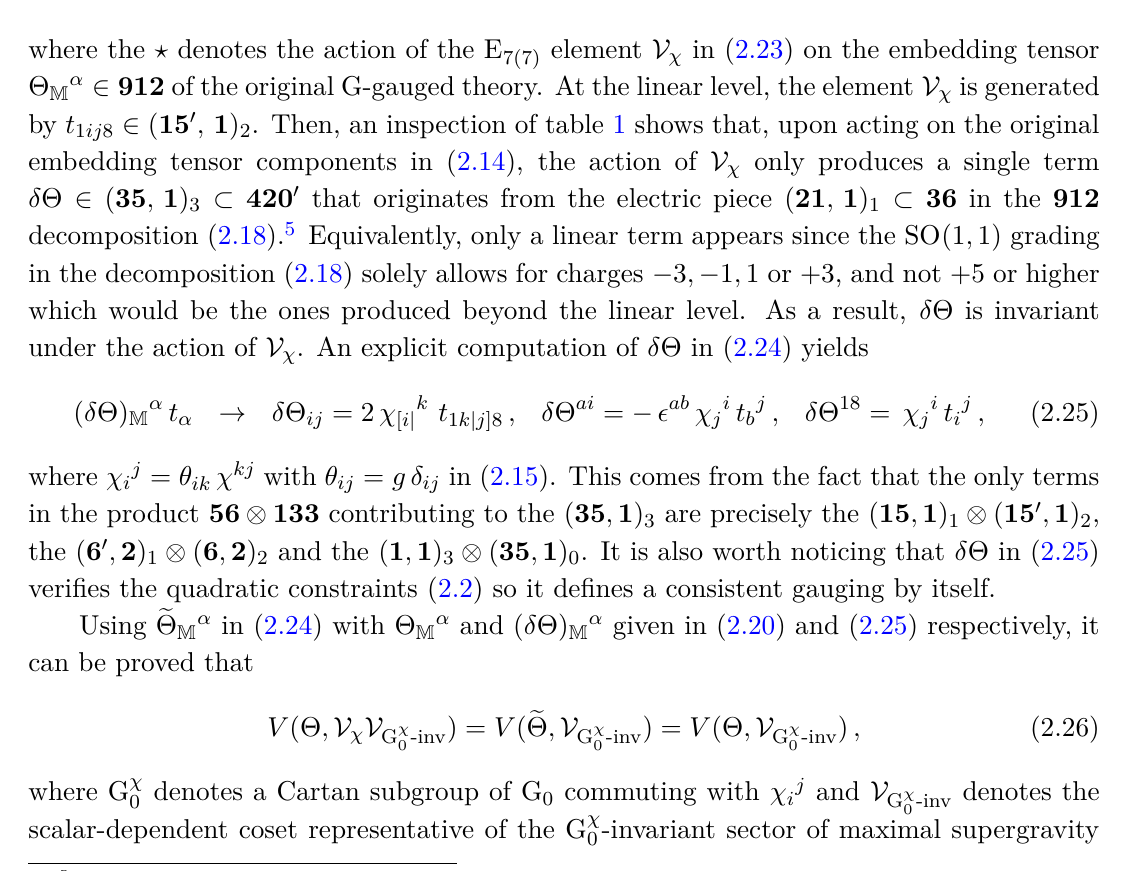
Table 1 . Group-theoretical action of the 133 representation of E SL (2) × SO (1 , 1) basis. Only pieces belonging to the 912 are